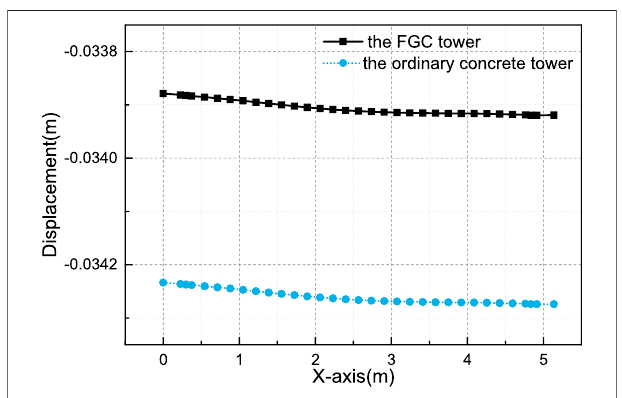
FIGURE 8 | The comparison of the displacements at the tower top.